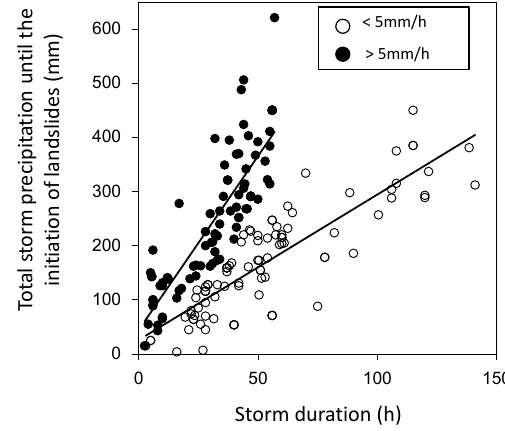
Figure 7. Storm rainfall–duration relationships with average inten- sities > 5 and ≤ 5mmh − 1 .